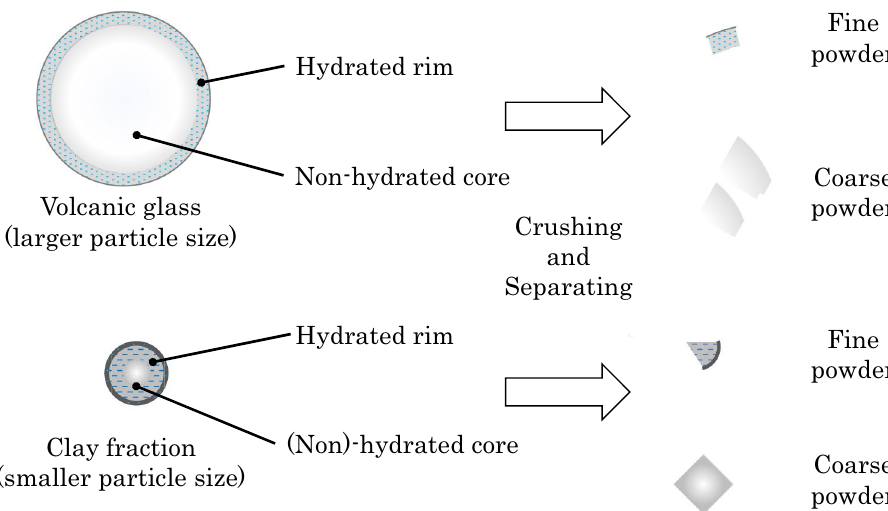
Fig. 24 Particle contained in volcanic ejecta and deposits and their crushing